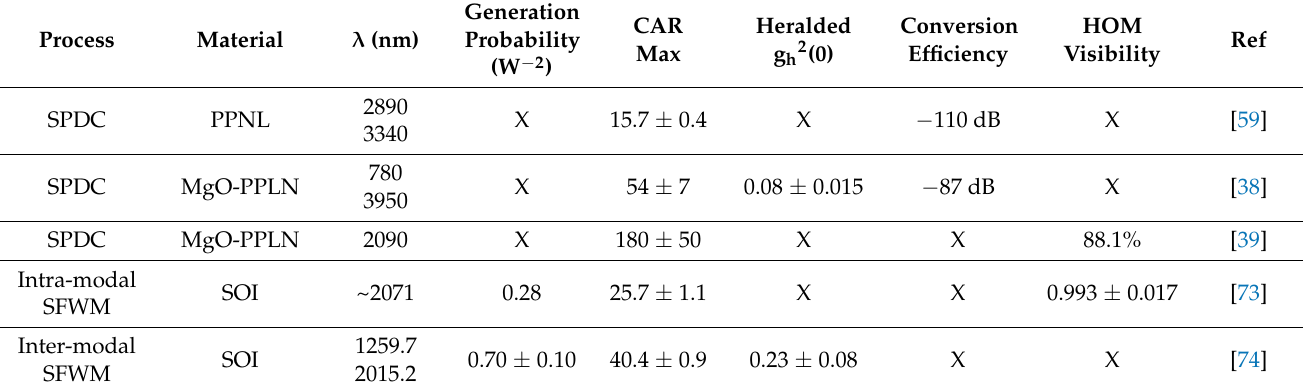
Table 1. Overview and comparison of the main results of the state of art for the photon-pair generation in the mid-infrared through parametric downconversion and four wave mixing. X: not